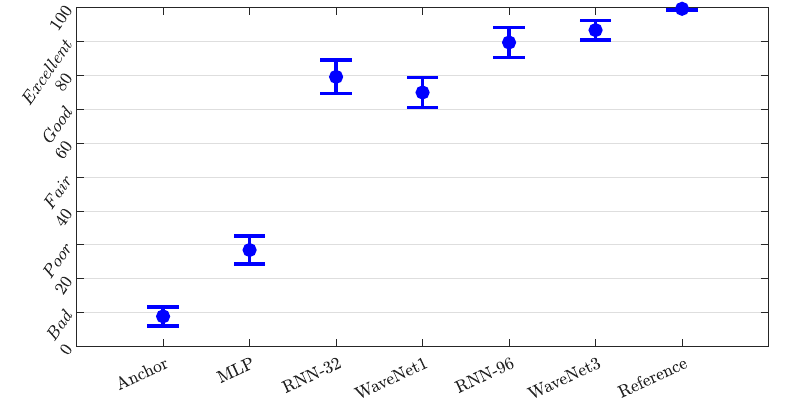
Figure 14. Mean results of MUSHRA test with 95% confidence interval, for models of the HT5M.